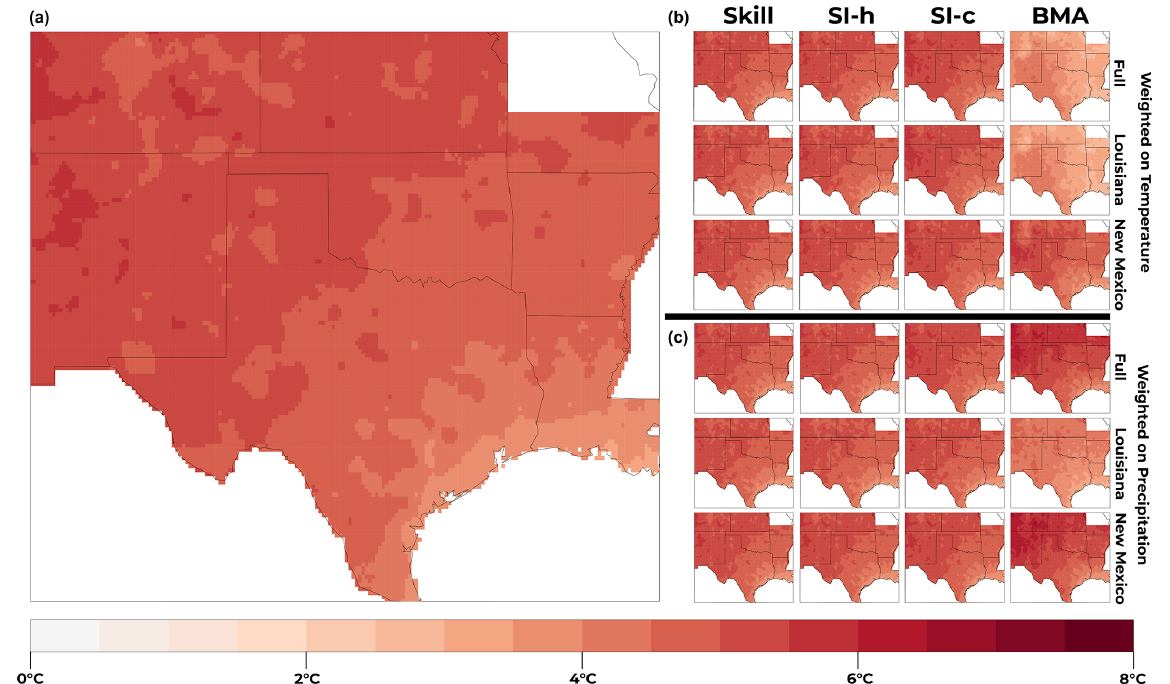
Figure 13. Same as Fig. 11, but for the mean projected change in high temperature from the LOCA